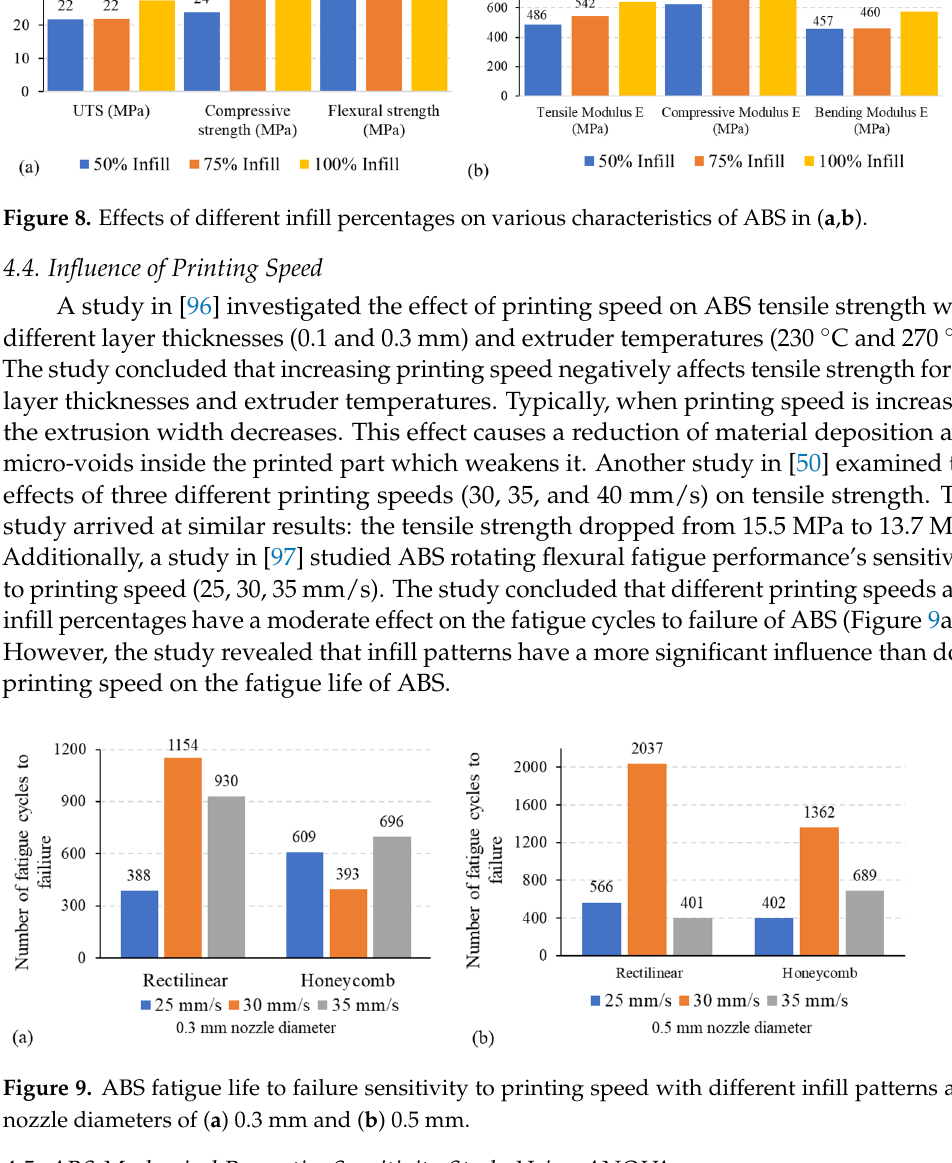
Table 4. Process parameters range used for ABS along with the related settings